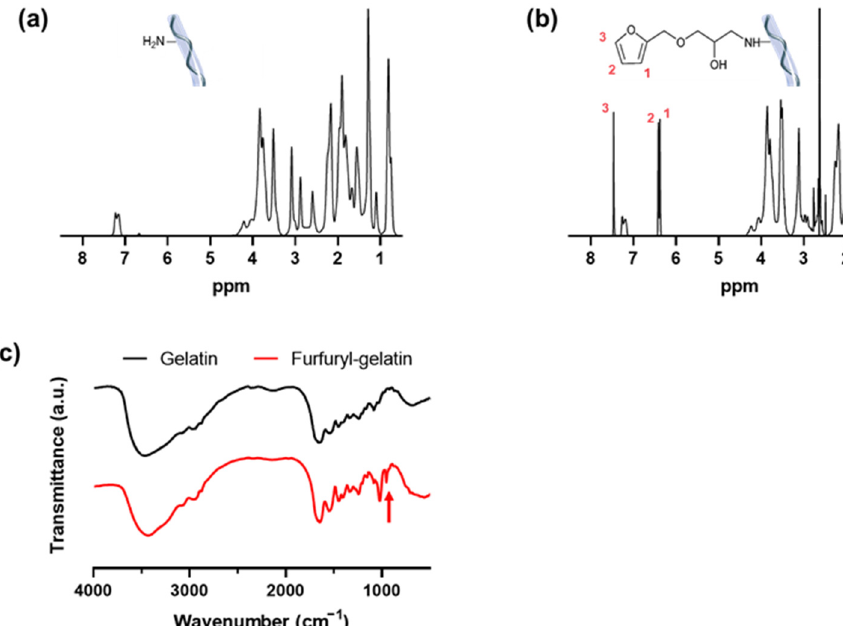
Figure 1. 1 H-NMR spectra of ( a ) gelatin and ( b ) furfuryl-gelatin. ( c ) FT-IR spectra of gelatin and furfuryl-gelatin.